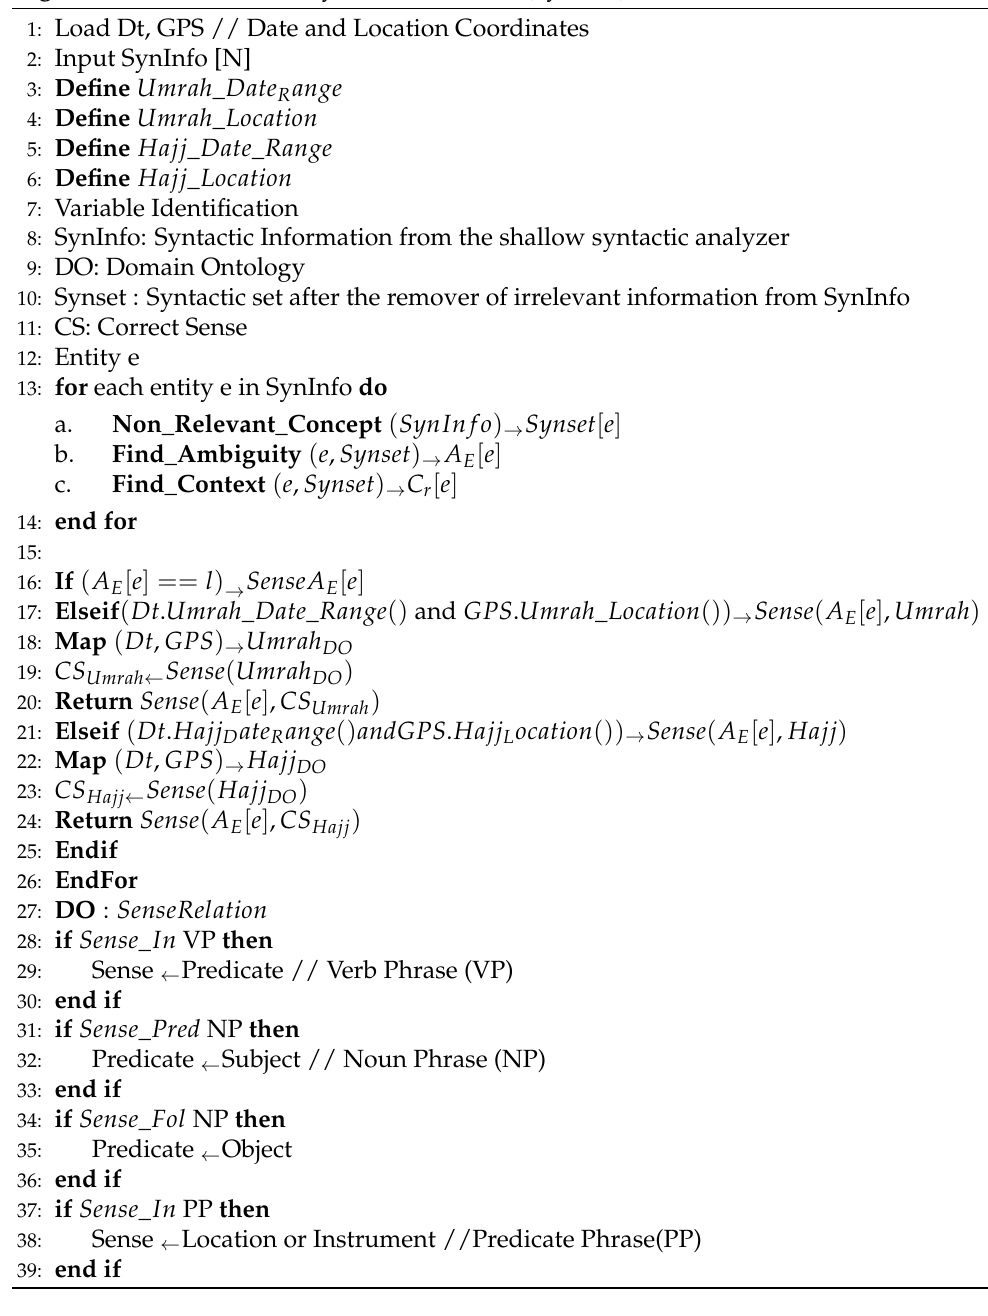
Algorithm 2 Semantic_Analysis_NL Question